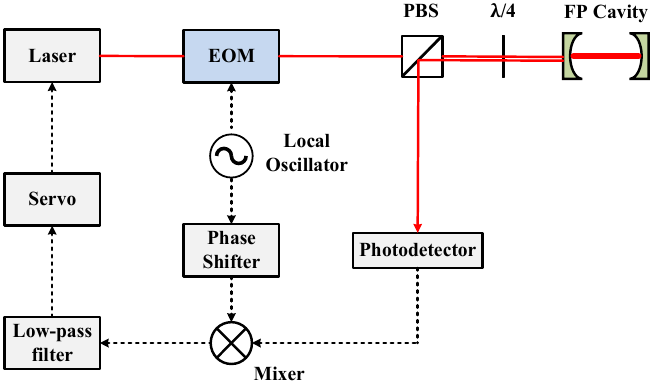
Figure 1. Schematic illustration of the PDH technique. PDH: Pound–Drever–Hall; EOM: electro–optic modulator; PBS: polarizing beam splitter; λ /4: quarter wave plate; and F–P: Fabry–Pérot.